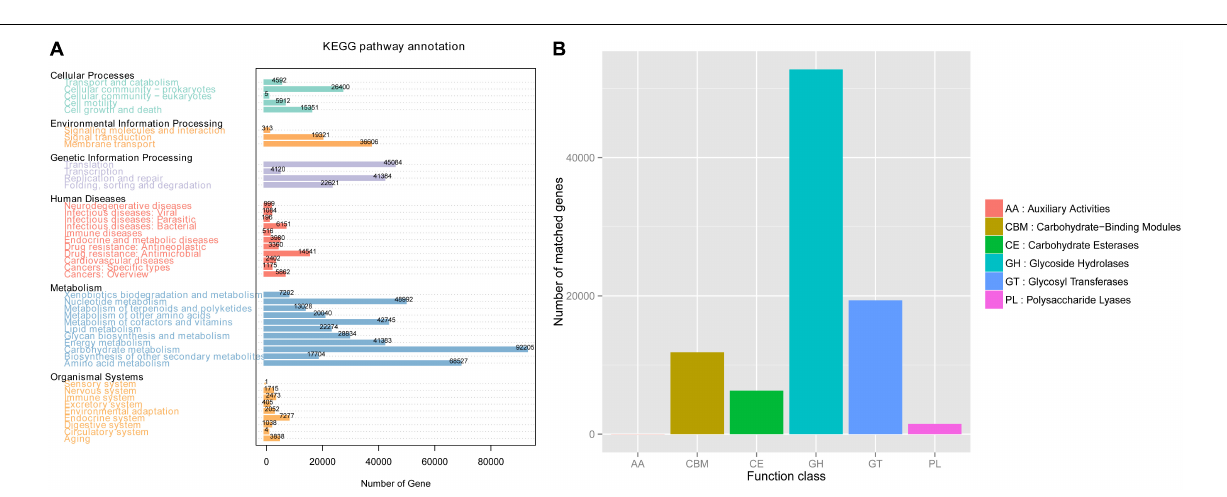
Frontiers in Microbiology |